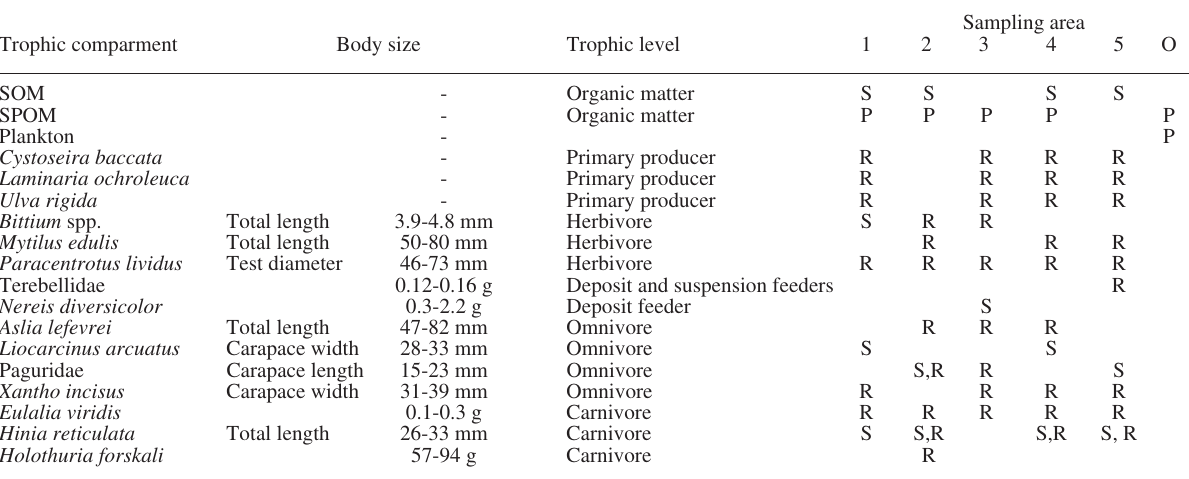
Table 2. – Food web compartments (organic matter sources and organisms) in the Golfo artabro sampled for stable isotope analysis. nominal trophic level, habitat type in which samples were taken (S= sandy substrates, r= rocky substrates, P= pelagic), sampling locations (see Fig. 1) and body size or fresh weight of organisms are